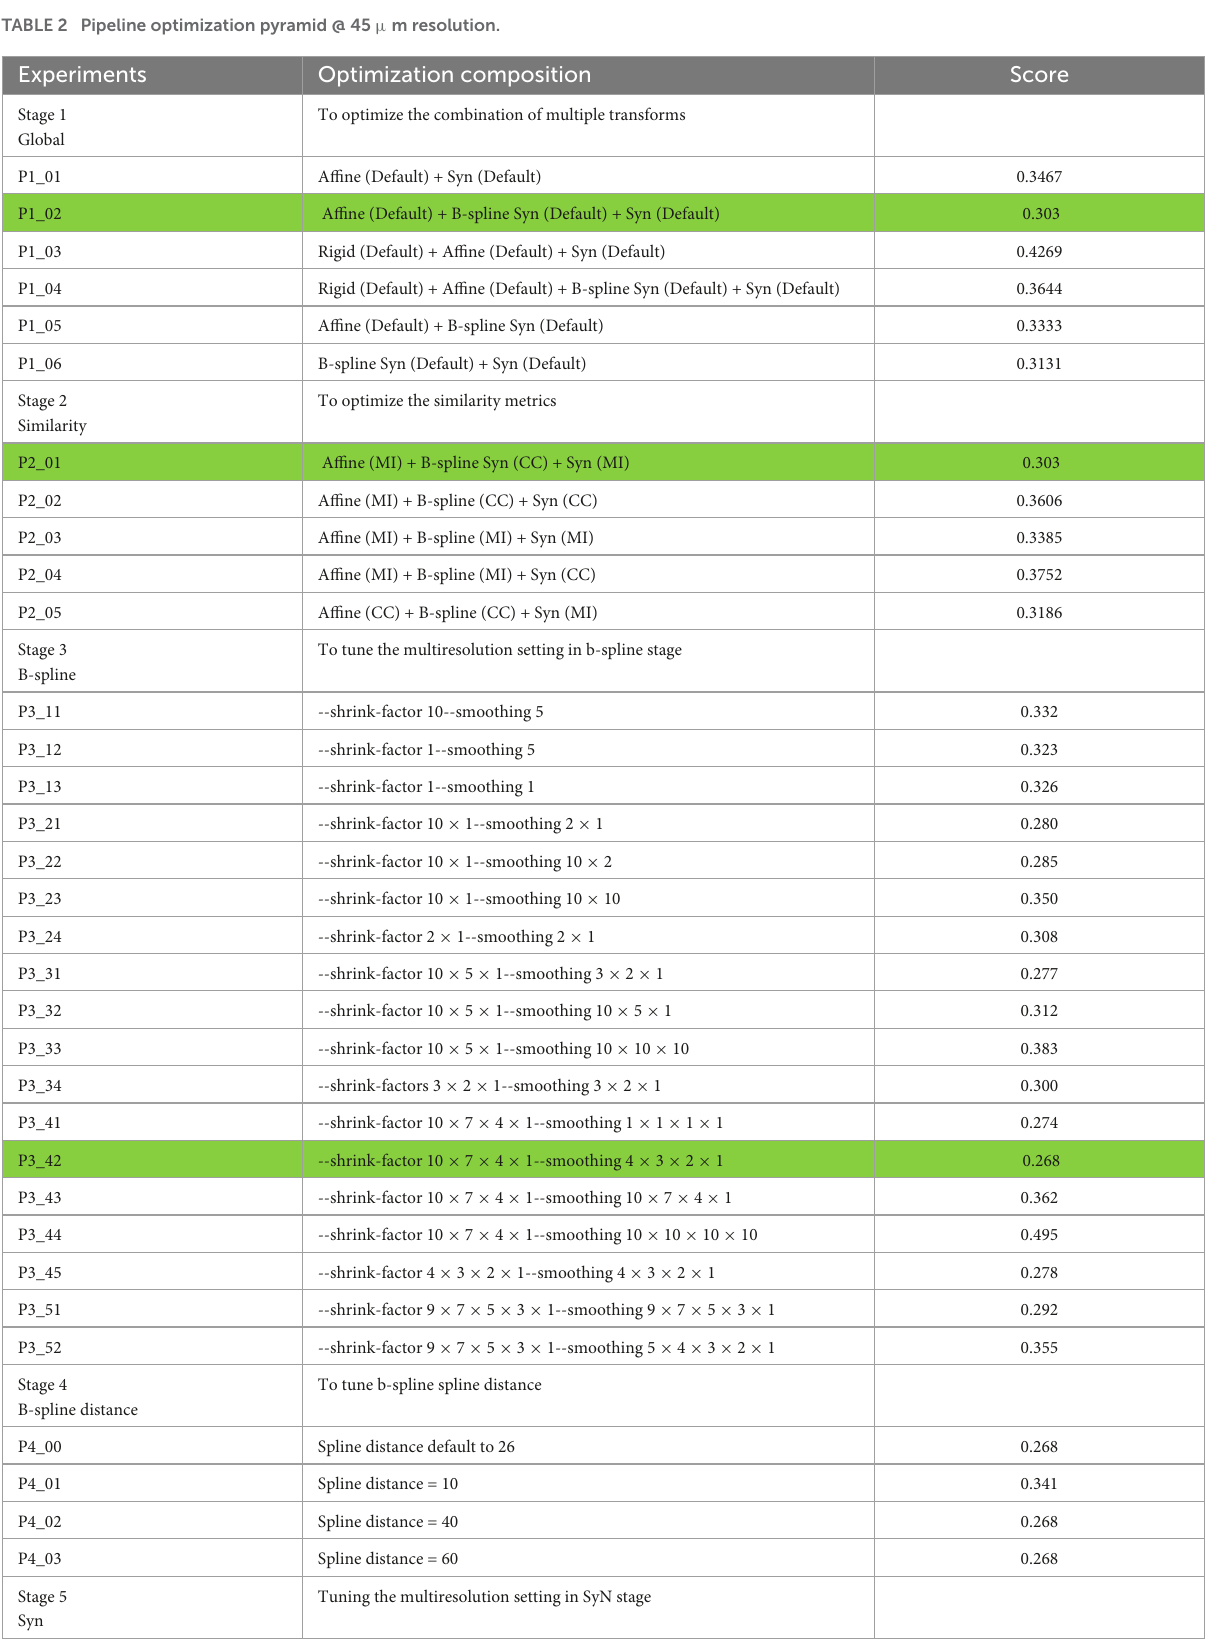
TABLE 2 Pipeline optimization pyramid @ 45 µ m resolution. Experiments Optimization